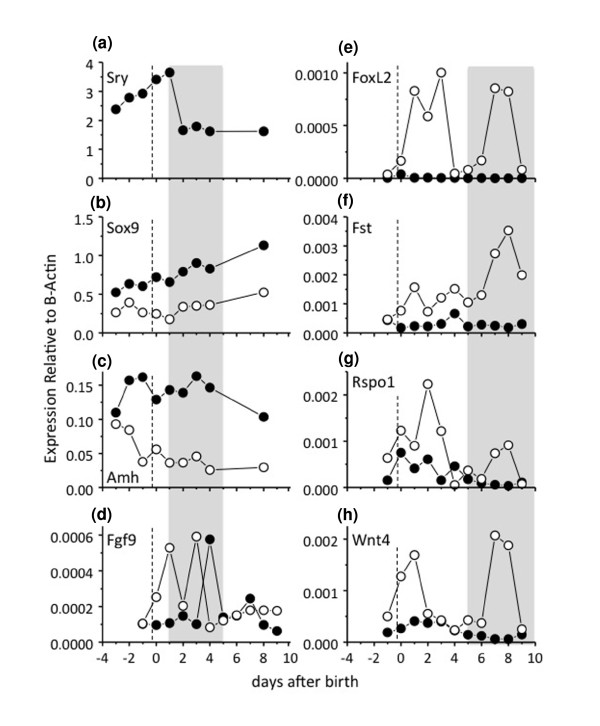
Quantitative mRNA expression for SRY, SOX9, AMH, FGF9, FOXL2, FST, RSPO1 and WNT4 during normal male (solid circles) and female (open circles) gonadal differentiation. Dotted line indicates day of birth, grey shading in a-d indicates the period of testis patterning and grey shading in e-h indicates the window of ovarian patterning. The critical period of testicular differentiation occurs between day 25 of gestation and day 2 postpartum, and that of ovarian differentiation between days 6-10 postpartum. P values from t-tests conducted to examine whether expression levels of the various genes were significantly different between males and females at each data point are shown in Additional file 1. Raw data for the mean ΔCt and standard deviations for each data point are shown in Additional file 5.